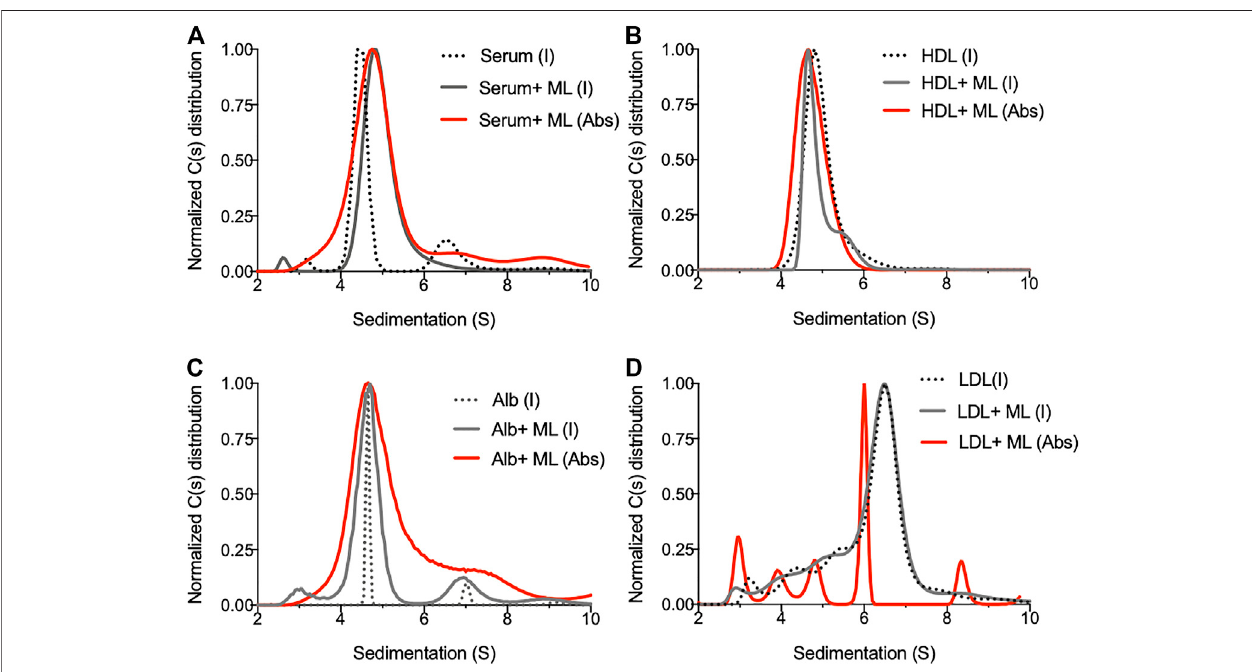
FIGURE 1 | Biophysical analysis of mycolactone behavior in solution. (A) Sedimentation pro fi le of species contained in human serum before (dotted line) and after addition of mycolactone (serum + ML, plain line) as detected by interferometry (I, gray line) or absorbance (Abs, red line). (B – D) Sedimentation pro fi les of human HDL (0.5 mg/ml) (B) human Albumin (Alb, 5 mg/ml) (C) or human LDL (0.5 mg/ml) (D) as detected by interferometry (I)or absorbance (Abs) in presence or absence of20 µM of mycolactone